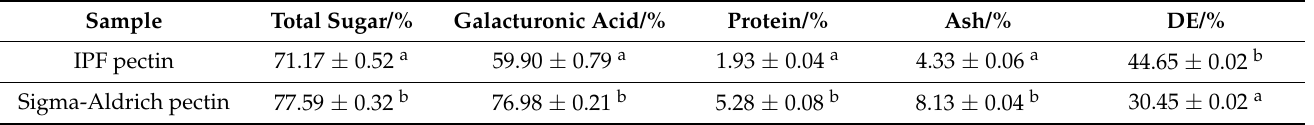
Table 4. Composition and content of IPF pectin and commercially available